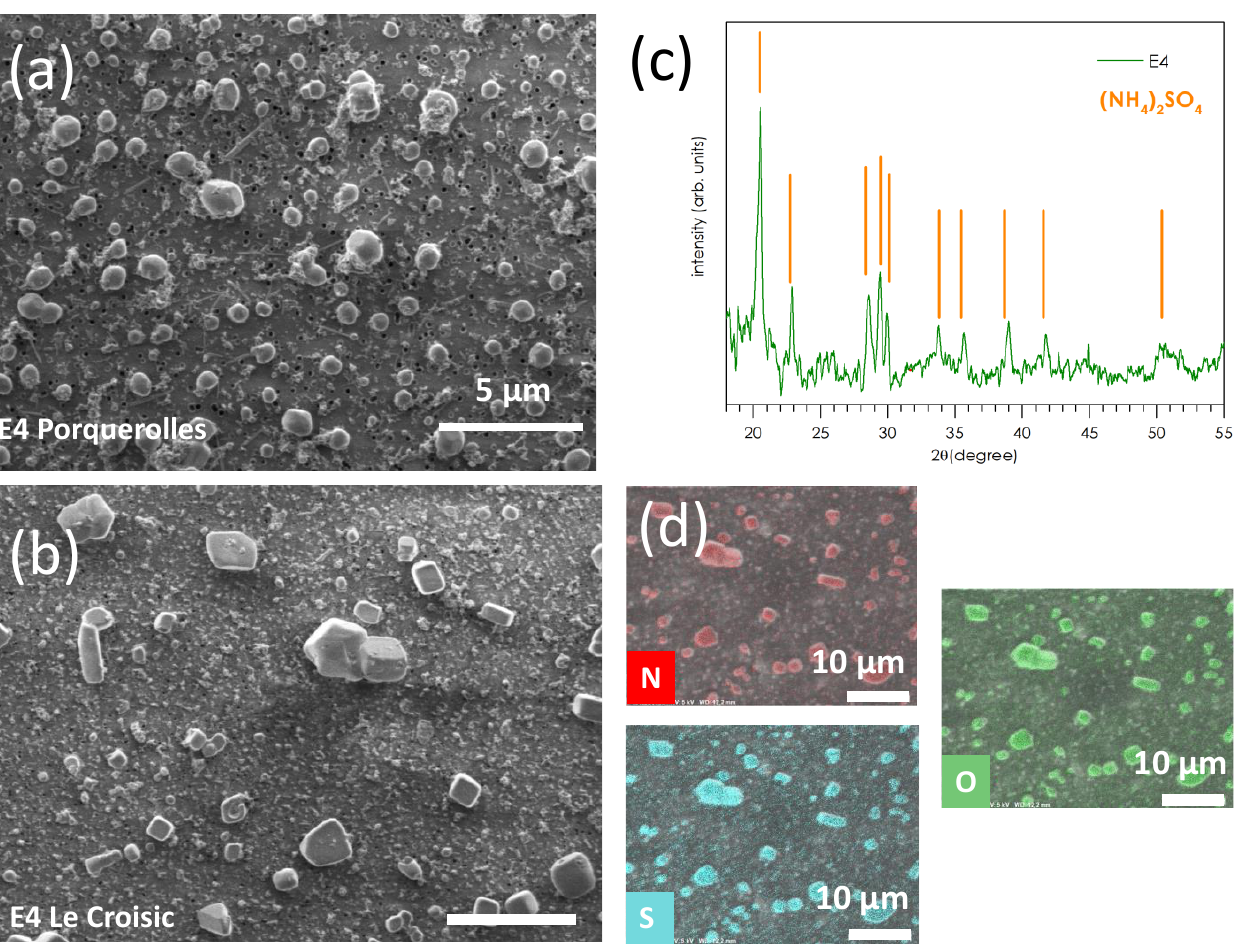
Figure 6. (a) SEM image of the E4 stage (D50% = 0.17 µm) of the Porquerolles sample P1 and ( b ) of the Le Croisic sample C4. ( c ) XRD spectrum of the E4 stage of the P1 sample; the angular positions of the diffraction lines of (NH 4 ) 2 SO 4 are indicated by orange lines. ( d ) EDX maps of the N, O, and S elements of the E4 filter of the C4 sample presented in ( b ).